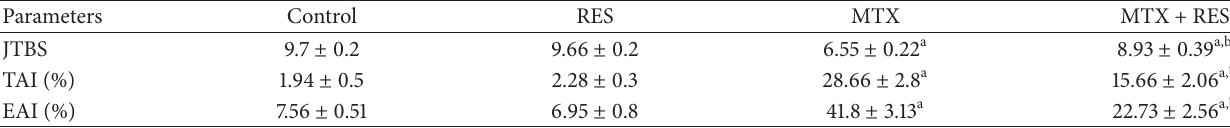
Table 2: Testis histopathologic damage scores and apoptotic index in all groups.